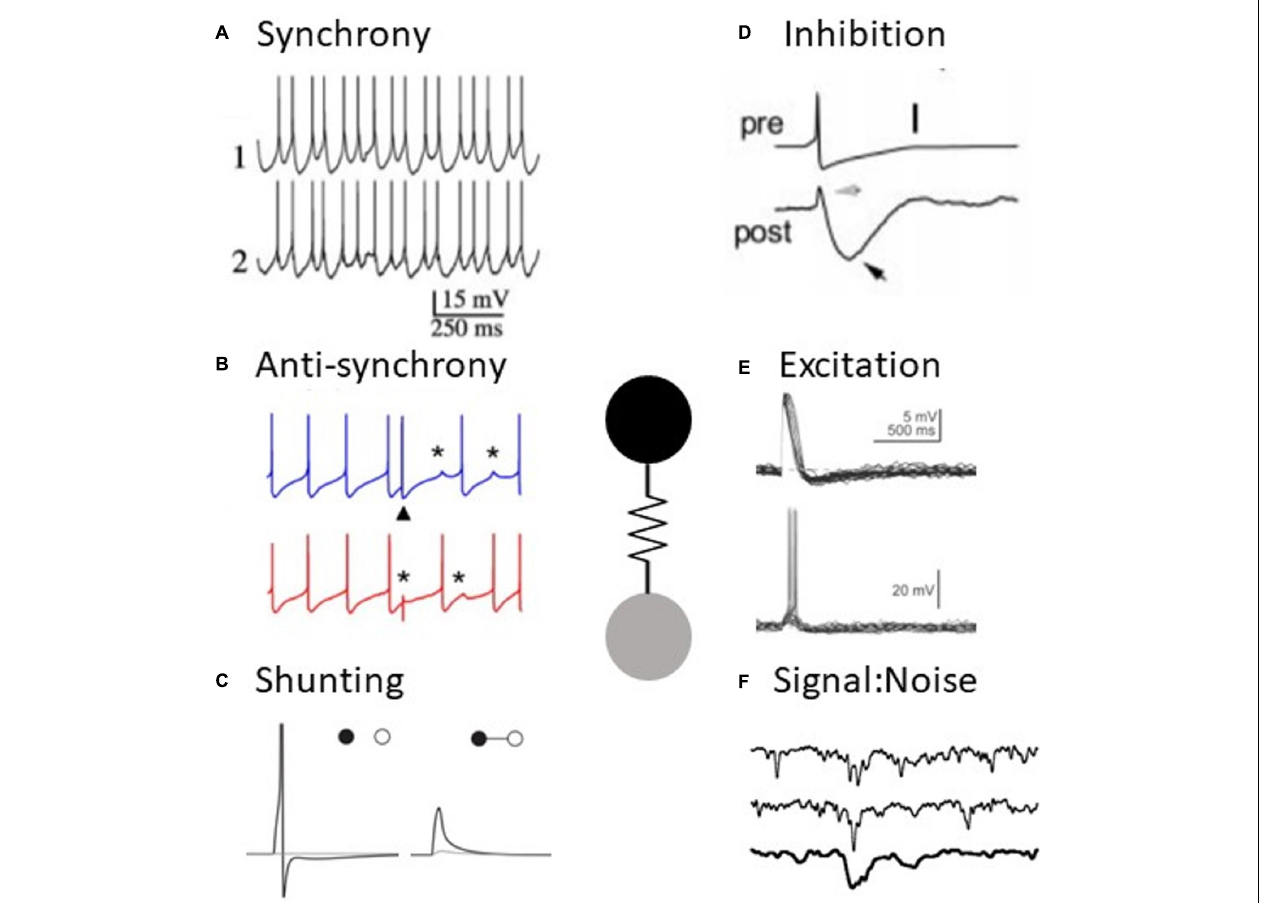
FIGURE 1 | Electrical synapses have diverse functions in neural processing. (A) Example of synchronous activity in coupled neurons (adapted from Long et al., 2004). (B) Example of anti-synchronous firing in coupled neurons (adapted from Vervaeke et al., 2010). (C) An electrical synapse (right) shunts an excitatory signal to one cell to subthreshold levels, compared to the uncoupled case (left) (adapted from Hjorth et al., 2009). (D) Slow spike afterhyperpolarizations appear as inhibition in a coupled neuron (adapted from Galarreta and Hestrin, 2001). (E) Spikes result in excitation in a coupled neuron (adapted from Apostolides and Trussell, 2014). (F) Example of a signal amidst noise in retinal neurons, impacted by the presence of electrical synapses (adapted from Dunn et al.,